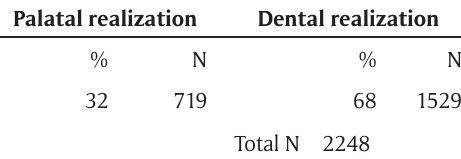
Table 9: Overall distribution of the realization of tokens of /ti/, /di/ in UP (1995